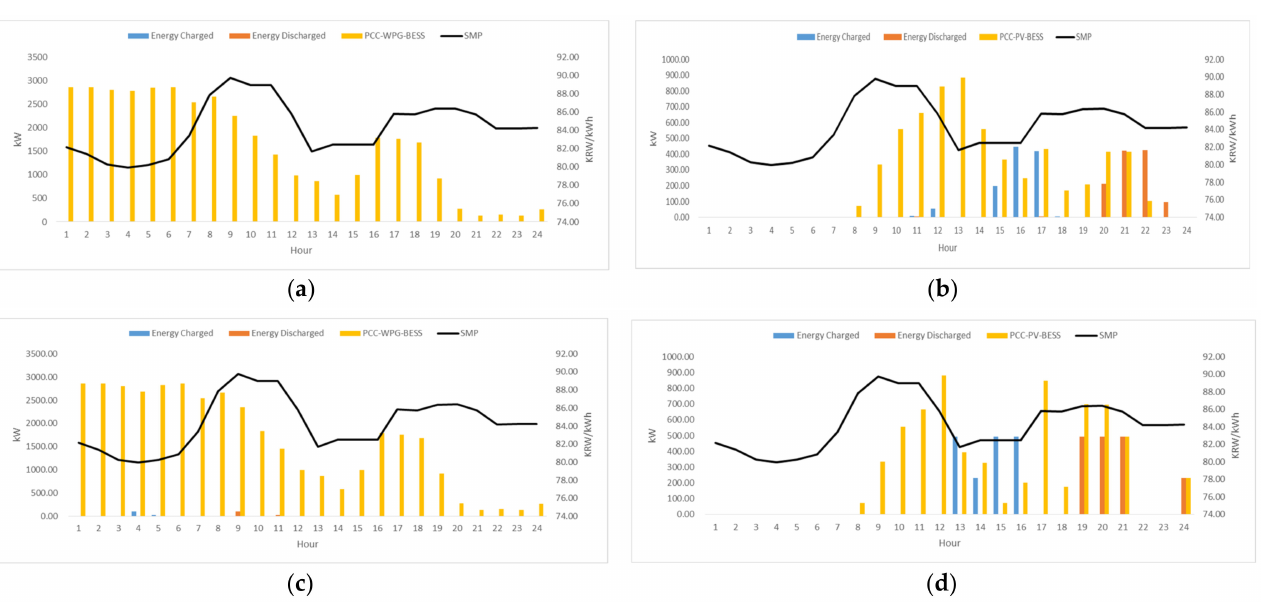
Figure 11. Operation between the BESS and the PV in coordination without profit maximization: ( a ) intraday operation of the BESS with WPG without profit maximization; ( b ) intraday operation of the BESS with the PV without profit maximization; ( c ) profit-maximized intraday operation of the BESS with the WPG; ( d ) profit-maximized intraday operation of the BESS with the